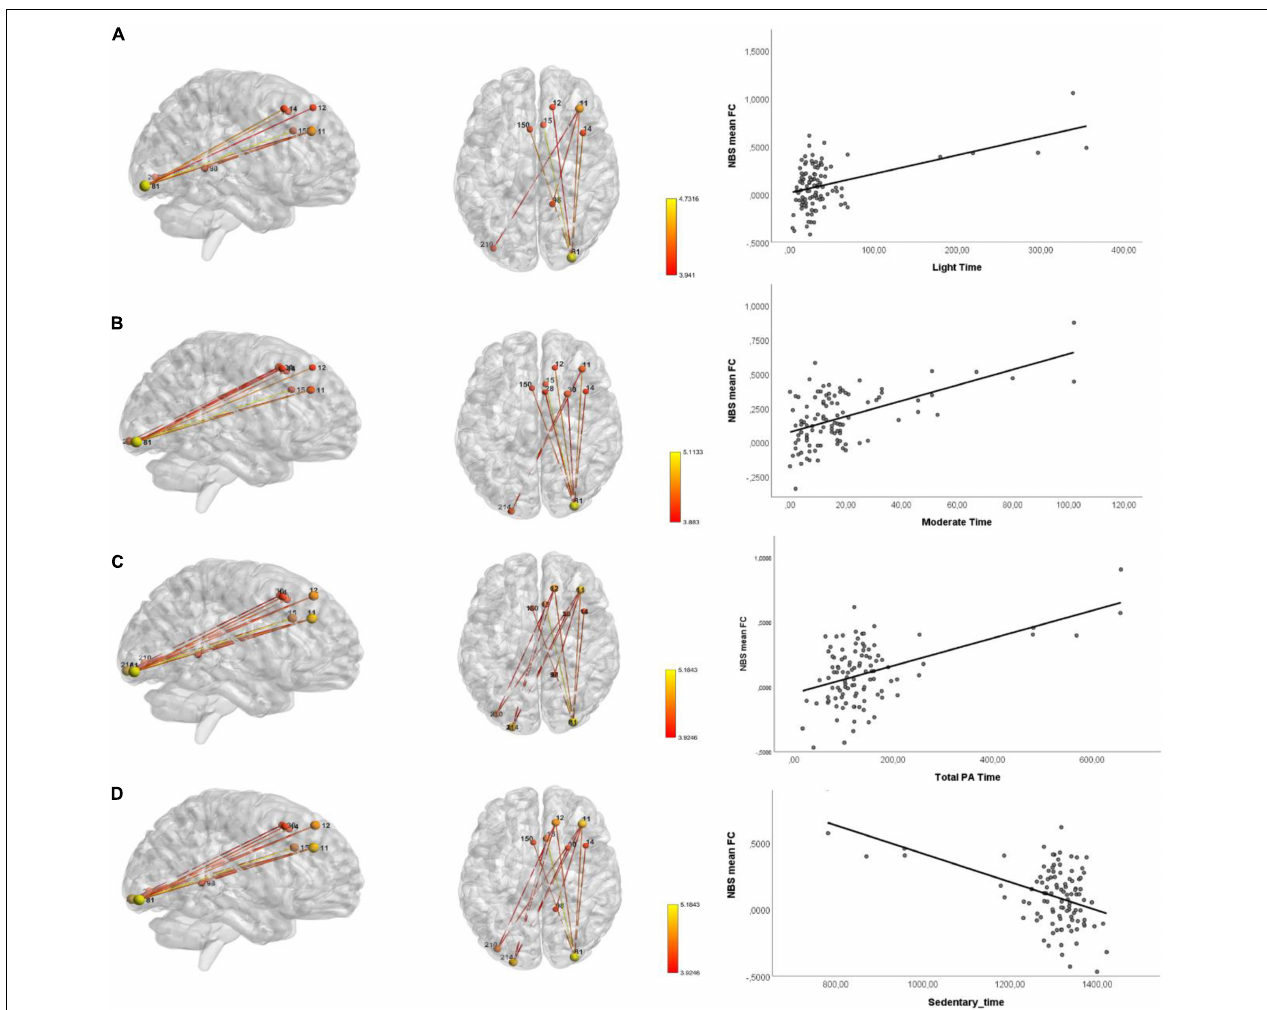
FIGURE 4 | Networks of FC identified using NBS showing increased connectivity during rs-fMRI acquisition. Sagittal and axial view of the network with nodes and edges colored in red-yellow color scheme representing the statistical t -value and the scatter plot showing the relationships between the mean FC and: (A) light time; (B) moderate time; (C) total PA time; and (D) sedentary time; after controlling for age, gender, age, MMSE, and